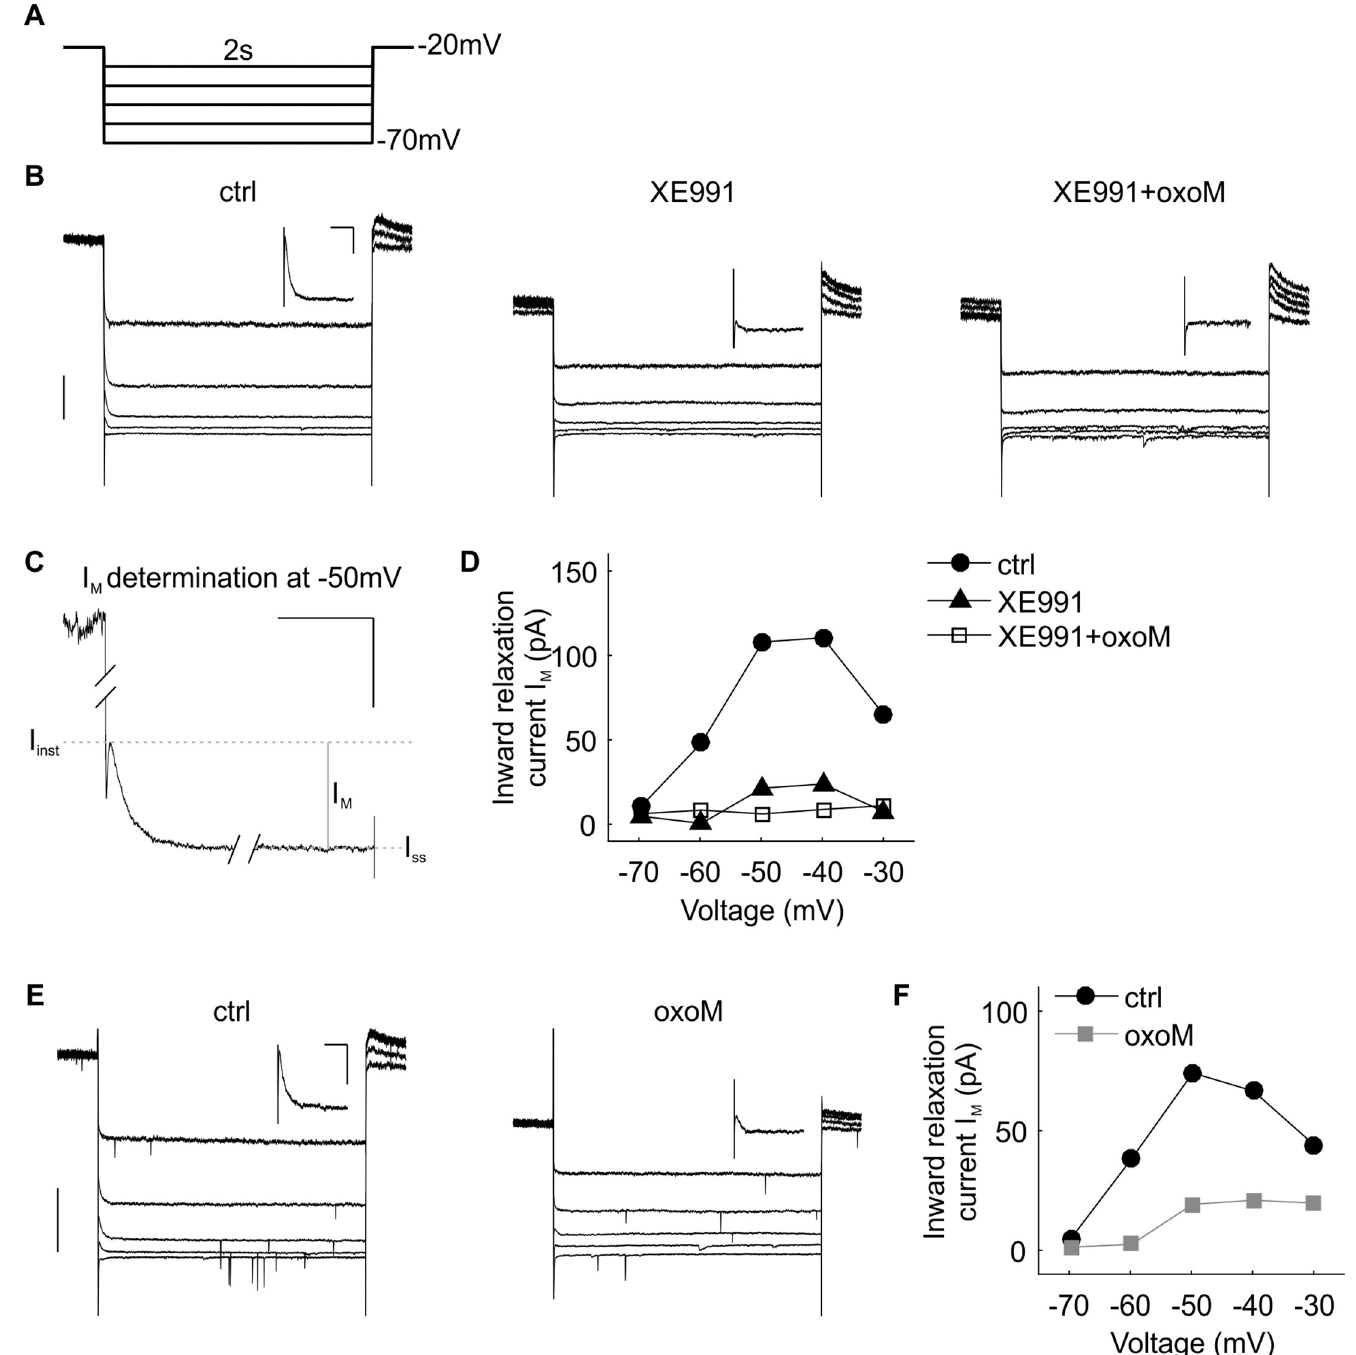
Fig 2. I M suppression by oxoM in an example cell. (A) Deactivation protocol with voltage steps (2 s) from -70 mV to -30 mV. (B) Example traces of current recordings in control (ctrl) condition (left part), after XE991 wash-in (middle part) and application of oxoM in presence of XE991 (right part); scale: 200 pA. The insets on the top right are magnifications of the -50 mV step; scale: 100 ms/50 pA. (C) Higher magnification of the -50 mV step in B (left part) showing how the inward relaxation, I M, was measured, i.e. by the difference between instantaneous I inst and steady state I ss currents; scale 100 ms/100 pA. A clear reduction of the inward relaxation was observed between the ctrl and XE991 conditions at -50 mV, see insets in B left and middle parts, while no further substantial change was noticed when oxoM is applied (B, right part). (D) Values of I M at each voltage for the cell shown in B. (E) Example traces of current recordings in control condition (left part) and after application of oxoM (right part); scale: 200 pA. The insets are the magnification of the -50 mV step; scale: 100 ms/50 pA. The inward relaxation I M was clearly reduced by oxoM. (F) Values of I M at each voltage for the cell shown in